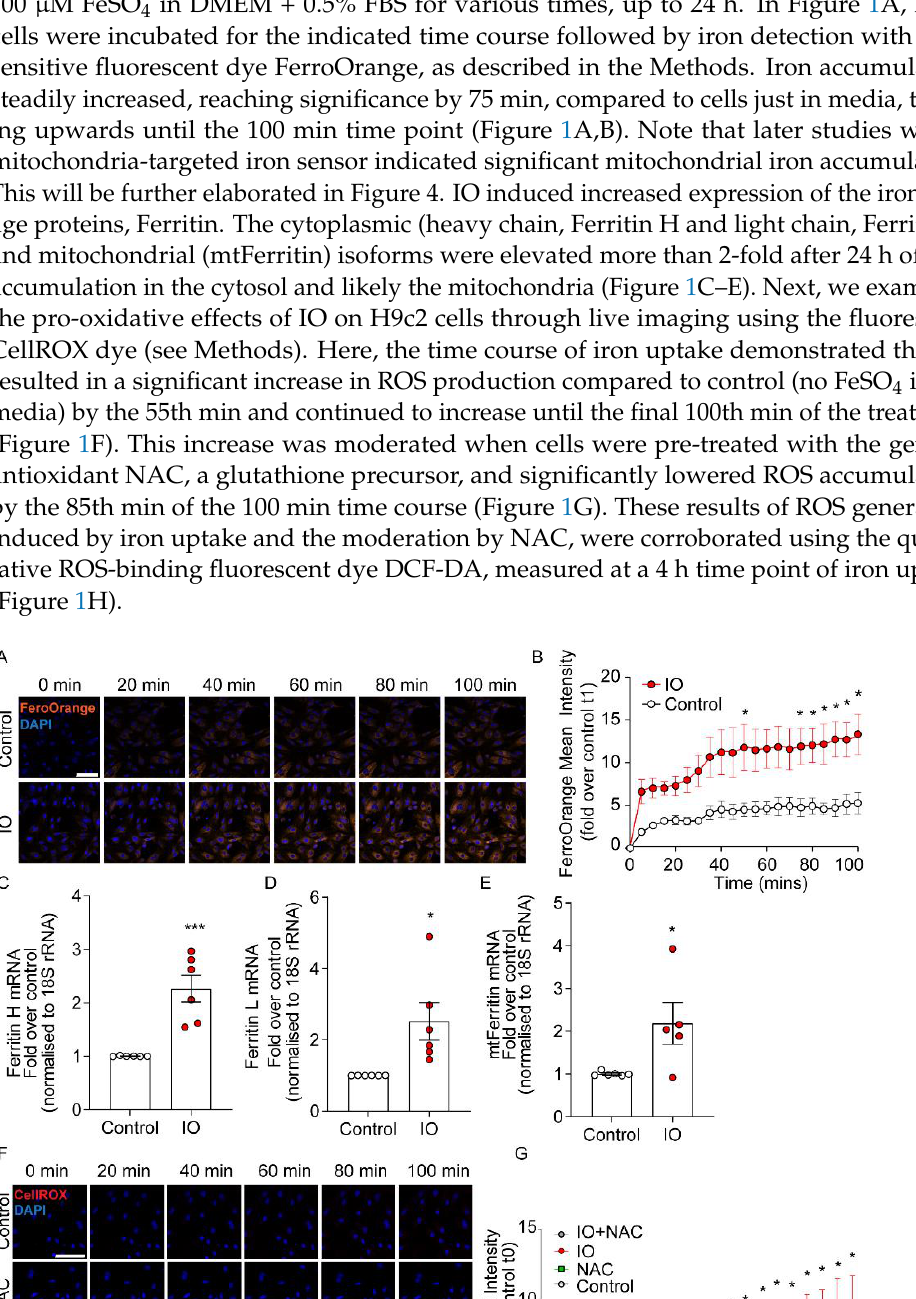
Figure 1. Characterization of intracellular iron and oxidative stress due to iron overload in H9c2. ( A ) Time-course of live-cell confocal imaging examining intracellular iron in H9c2 cells, using Fer- roOrange and Hoechst nuclear dye (blue). Cells were treated with 100 µM FeSO 4 concurrently with FerroOrange dye (1 µM) and Hoechst (100 nM). ( B ) Fluorescence mean intensity of FerroOrange in IO or control was measured at 5 min intervals and calculated as the fold over Control at t1 (5 min time point) for both conditions (n = 4). ( C – E ) H9c2 were cultured in 6-well plates and cultured with 100 µM FeSO 4 , or not (Control), for 24 h. ( C ) Quantification of Ferritin Heavy and ( D ) Light chains mRNA (normalized to 18S rRNA) and ( E ) mito-Ferritin mRNA (normalized to 18S rRNA), pre- sented as fold over Control (n = 6). ( F ) Time-course of live-cell confocal imaging examining ROS production under IO (100 µM FeSO 4 ), using CellROX Deep Red (Red) and Hoechst to stain nuclei (blue). NAC (500 nM) was used as a ROS inhibitor added 30 min prior to the start of IO. ( G ) Fluo- rescence mean intensity of CellROX Deep Red was measured at 5 min intervals and calculated as the fold over control at t1 (5 min time point) for all conditions (n = 4). ( H ) Quantification of ROS production under IO (4-h) with DCF-DA ROS dye (see Methods). NAC was used as a ROS inhibitor added 30 min prior to IO treatment (n = 5). Scale bars in B and G denotes 50 µm. * p < 0.05, *** p < 0.001, **** p < 0.0001 relative to Control; # p < 0.05, ## p < 0.01 relative to IO. 3.2. Increased ROS Production Mediates Apoptosis in H9c2 Cells Next, we investigated the role ROS production plays in the mediation of H9c2 cell death. Cleavage of Caspase 3 is a key intersection point of apoptotic pathways. Here, we